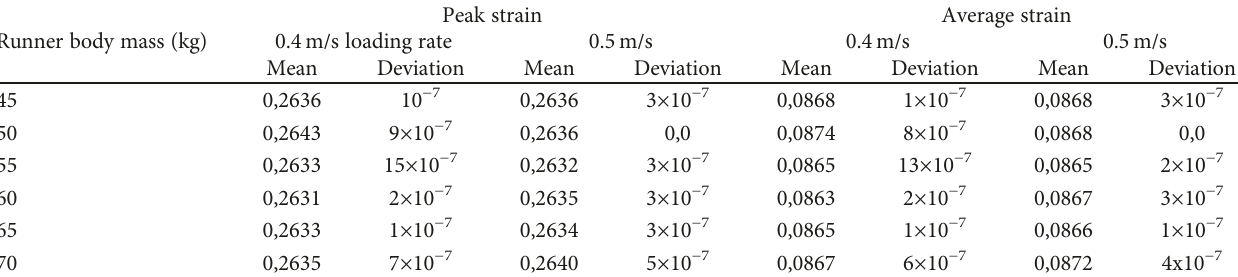
Table 1: Runner body mass-dependent strain (peak and average) of the tested midsole system. Runner body mass